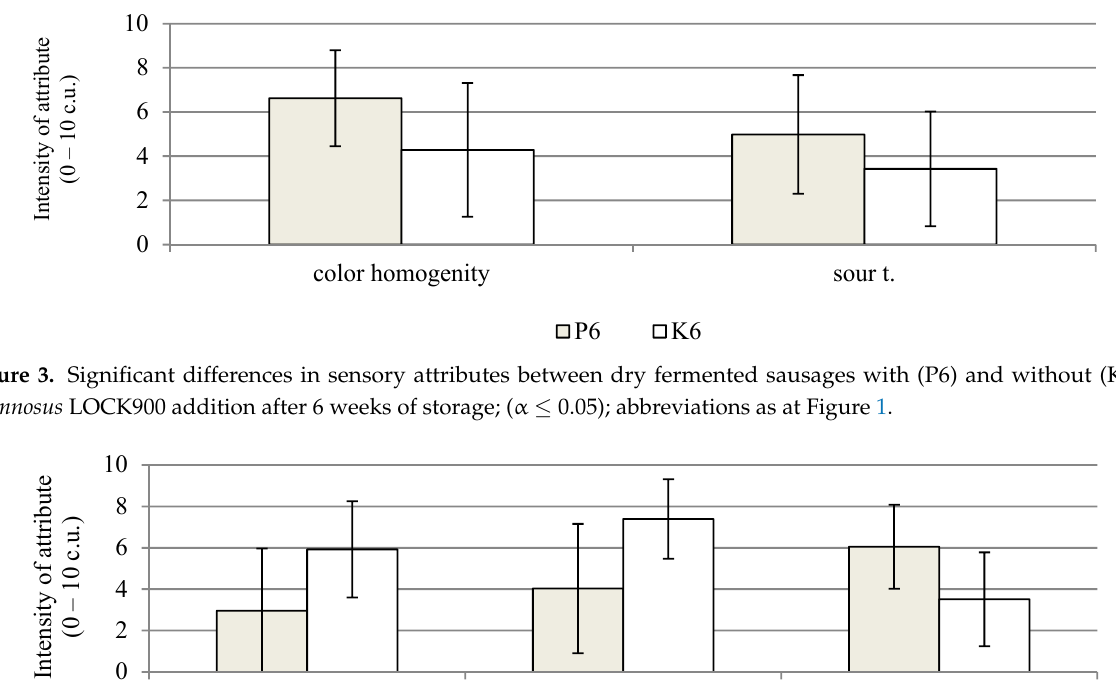
Figure 2. Significant differences in sensory attributes between dry fermented sausages with (P0) and without (K0) L. rhamnosus LOCK900 addition after fermentation process; ( α ≤ 0.05); abbreviations as at Figure 1.